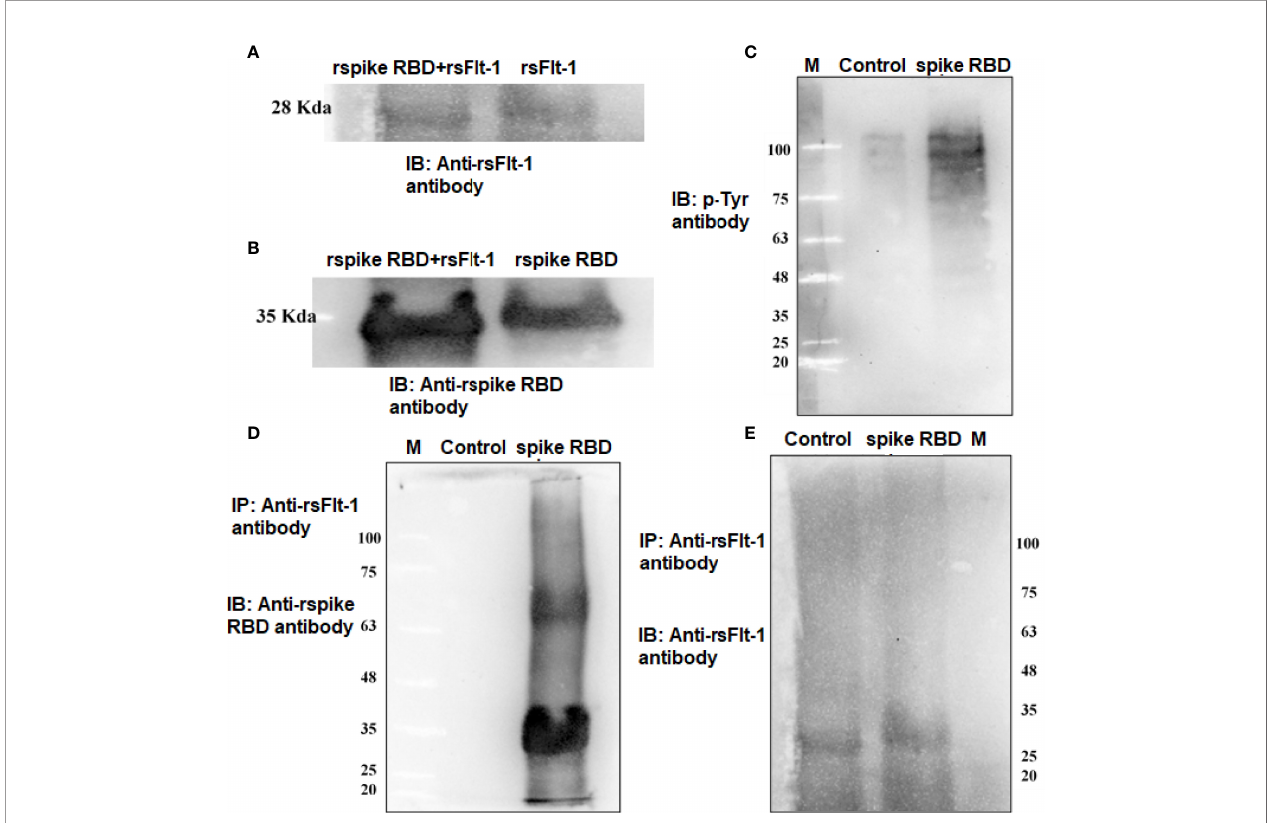
FIGURE 6 | Detection of binding of rspike RBD with cell surface Flt-1 receptors using immunoprecipitation and immunoblotting: (A) Lane1 is immunoblot of rspike RBD-rsFlt-1 complex (pre-incubated for 2-hours prior to run on the gel) and lane 2 is rsFlt-1 protein, both lanes probed with anti-sFlt-1 antibody. (B) Immunoblot of rspike RBD- rsFlt-1 complex (lane 1) and rspike RBD (lane 2) probed with anti-Spike RBD antibody. (C) Immunoblot of untreated and rspike RBD treated cell lysate probed with p-Tyr antibody indicates more phosphorylation in treated lysate compared to control. (D) IP of rspike RBD of A549 treated cell lysates with anti-sFlt-1 antibody followed by IB with anti-spike RBD antibody shows clear bands in treated lane compared to the absence of bands in untreated cells revealed precipitation of cellular bounded spike RBD by the anti-sFlt-1 antibody. (E) IP of cell lysates using sFlt-1 antibody and IB with anti-sFlt-1 antibody showing bands in both treated and untreated cells due to presence of sFlt-1 receptor on the cells regardless of the